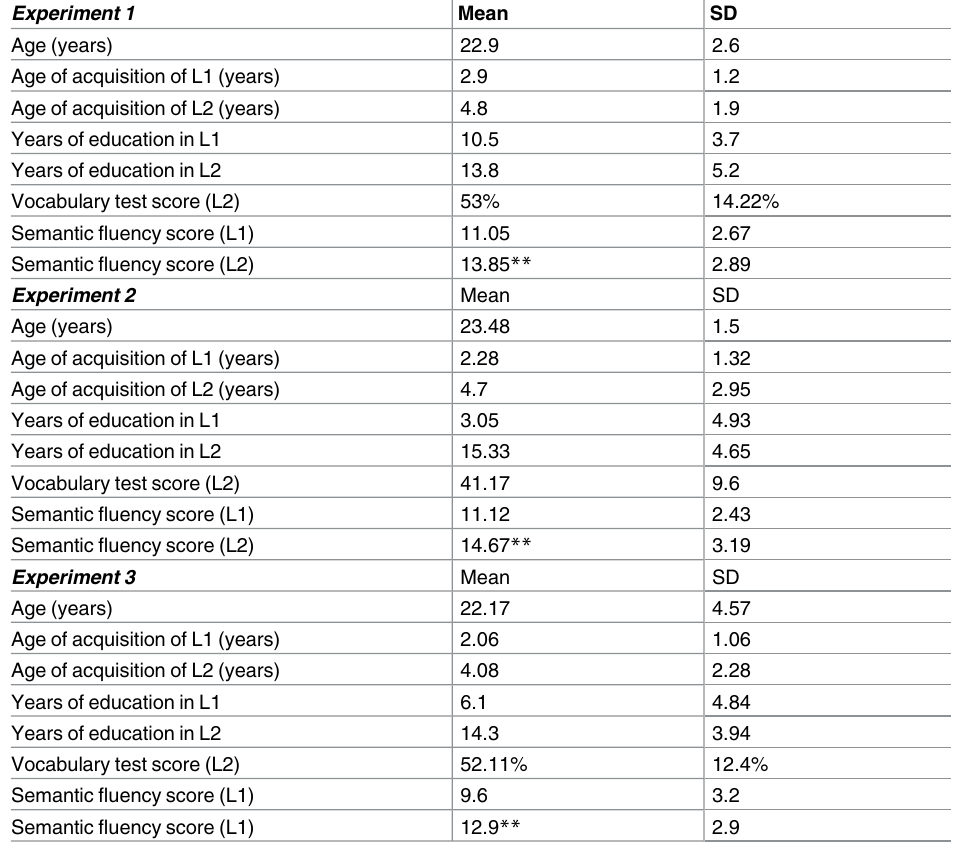
Table 1. Language and demographic data of the participants in Experiments